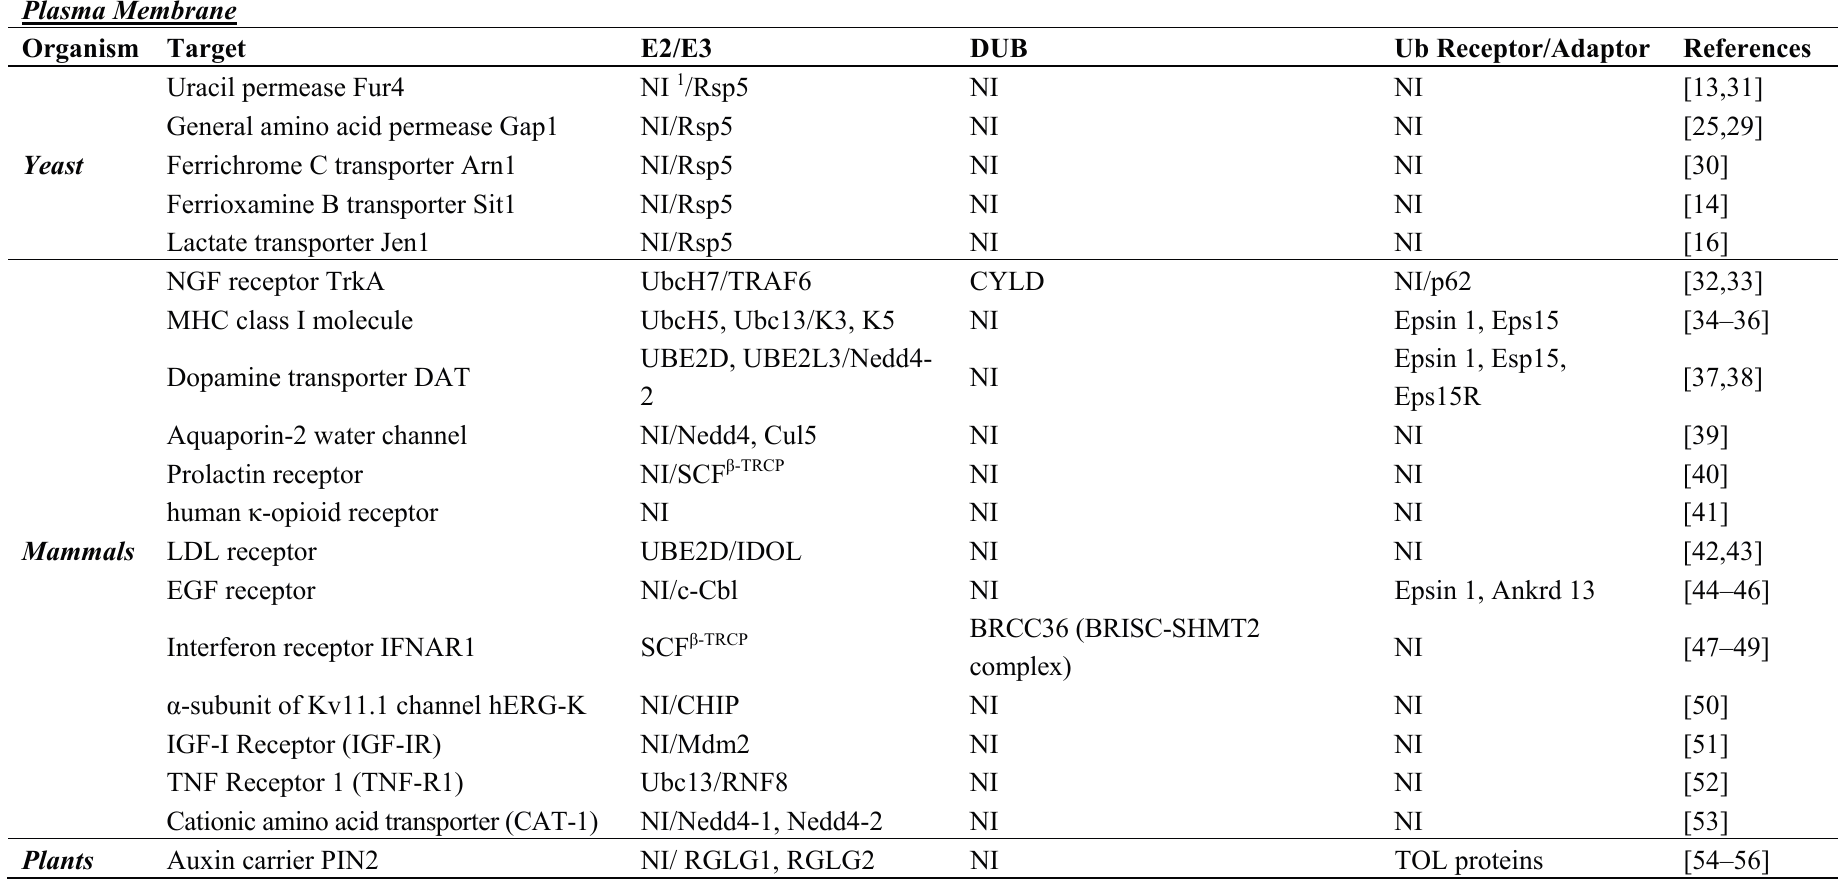
Table 1. List of UbK63 chain targets along different trafficking